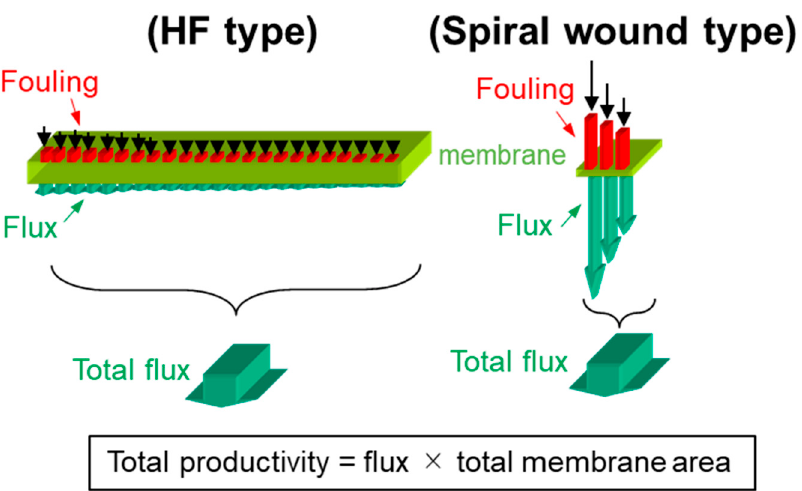
Figure 4. Comparison of fouling risk in membrane type [28].